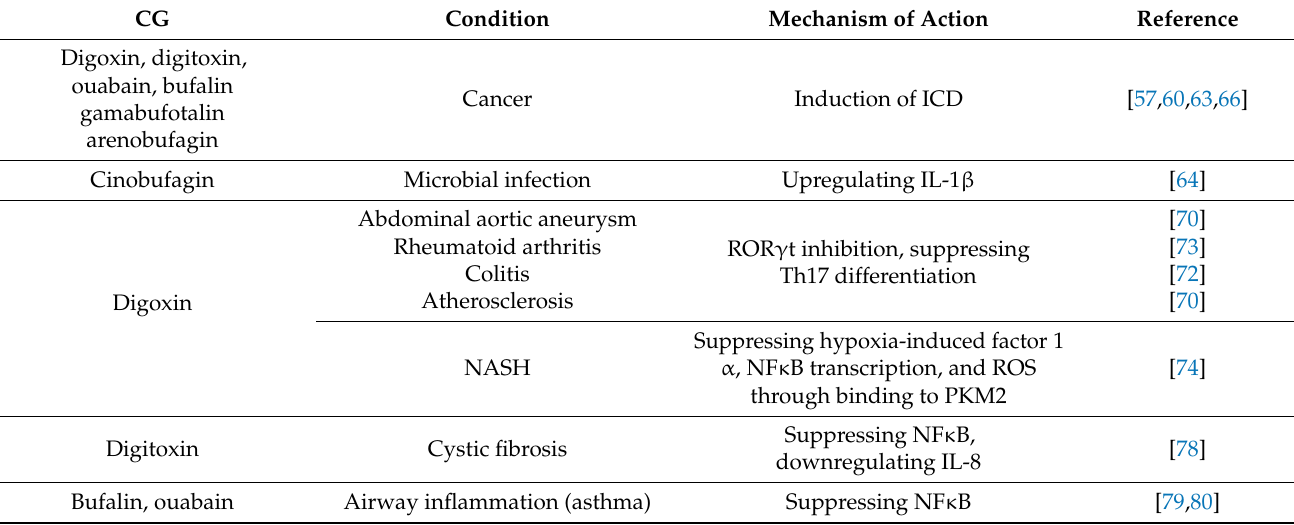
Table 1. Potential therapeutic opportunities for cardiac glycosides (CGs) and the main mechanism of action against particular